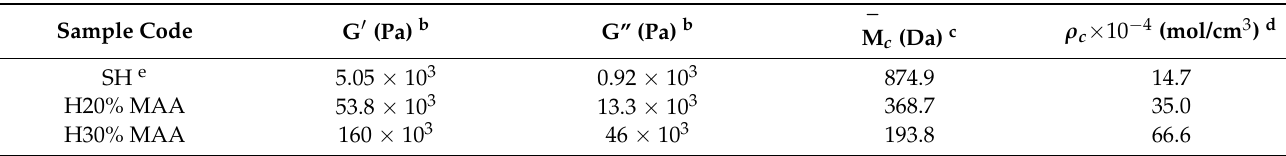
Table 2. Dependence of the viscoelastic moduli (frequency sweep measurements) and some structural network parameters on the monomer concentration a .